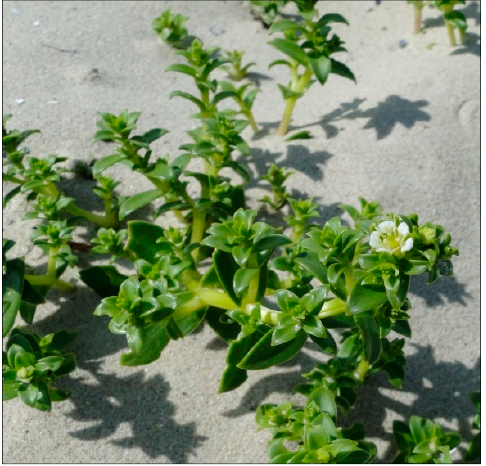
Figure 2. Flowering of Honckenya peploides.